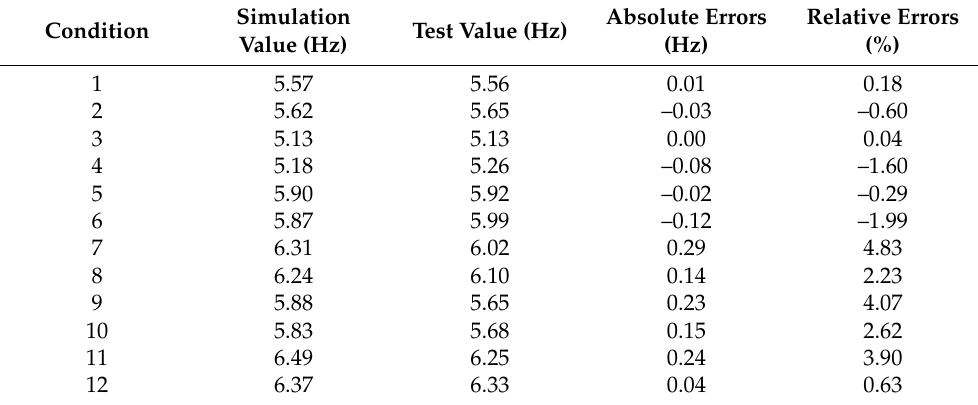
Table 4. The validation of operating